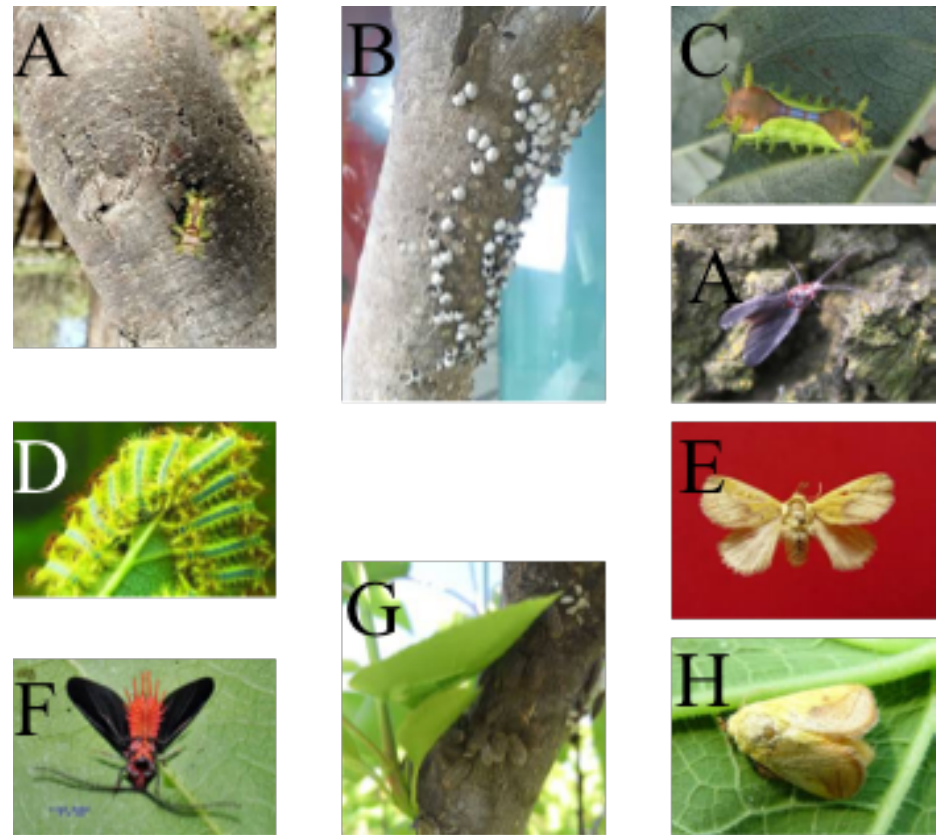
Figure 2. Illustration of different species of pest data sets. ( A , C ) are Cnidocampaflavescens (Walker, larva). ( F , I ) are Cnidocampaflavescens (Walker, adult). ( B ) is Erthesinafullo (Thunberg, egg). ( D , G ) are Drosicha corpulenta (Kuwana, adult). ( H ) is Drosicha corpulenta (Kuwana, larva). ( E ) is Parasa conso- cia